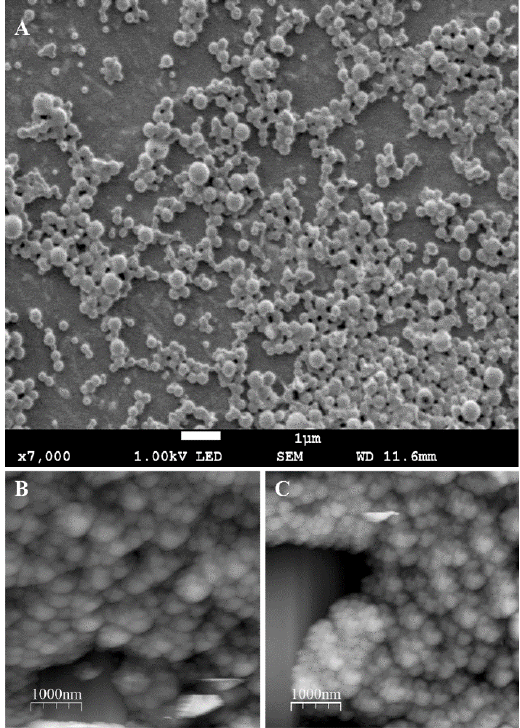
Figure 4. ( A ) Scanning electron microscopy (SEM) images of pDNA ‐ NP with 0.8% theoretical pVAX1 ‐ NH36 loadings (TDL). Atomic force microscopy (AFM) images of pDNA ‐ NP with ( B ) 0.2% TDL; and ( C ) 0.5% TDL.